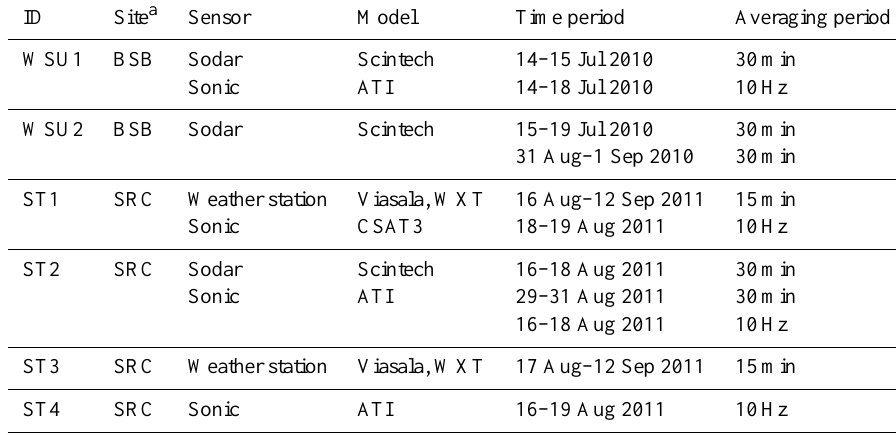
Table 1. Sonic anemometer and vertical profiling sensor details. ID Sensor Model